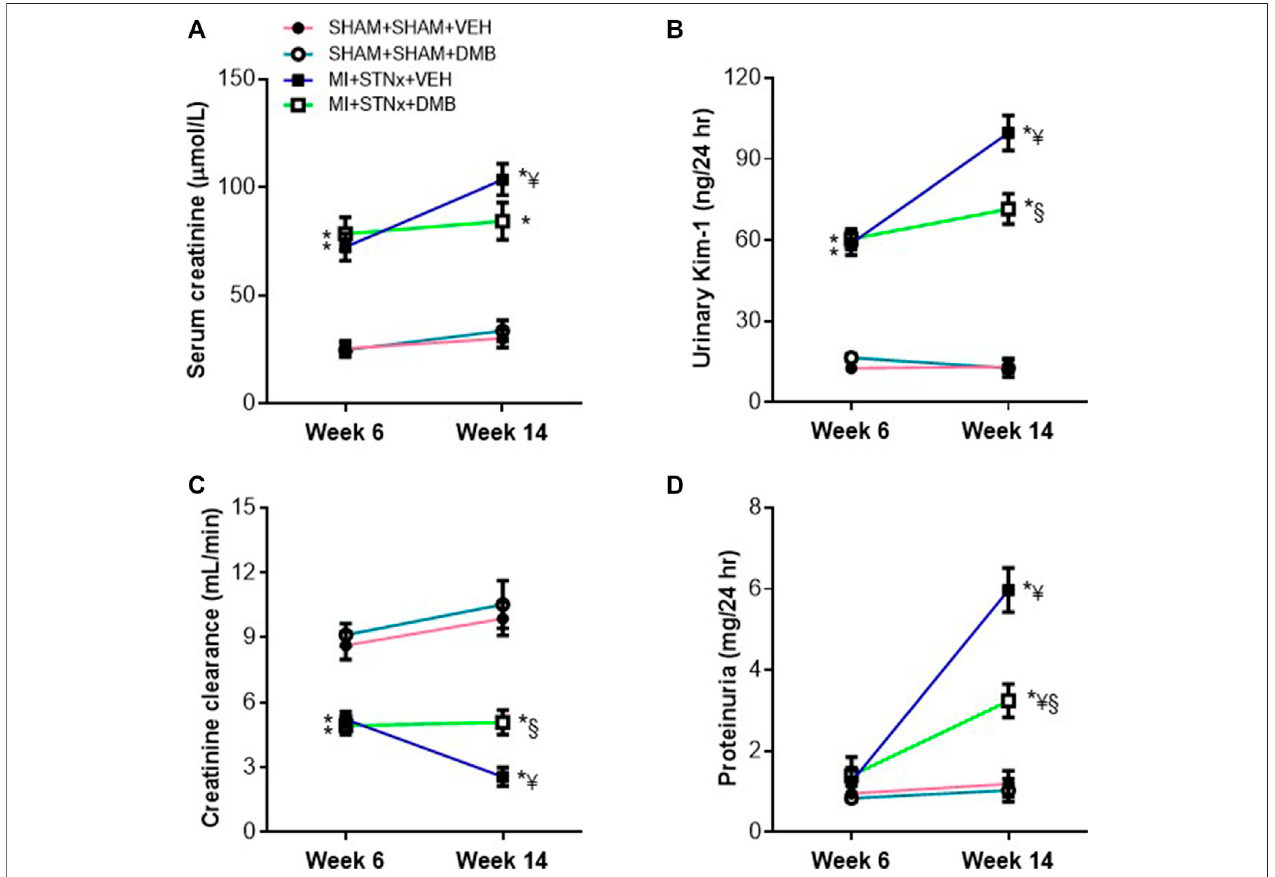
FIGURE 3 | Effects of CRS2 and DMB treatment on renal function assessed by serum creatinine concentrations (A) , urinary kidney injury molecule-1 (Kim-1) (B) , creatinine clearance (C) and proteinuria (D) . Data are expressed as mean ± SE ( n (cid:1) 8 – 10 for each group). * p < 0.05 vs SHAM + SHAM + VEH at each time point; ¥ p < 0.05 vs week 6; § p < 0.05, MI + STNx + DMB vs MI + STNx +